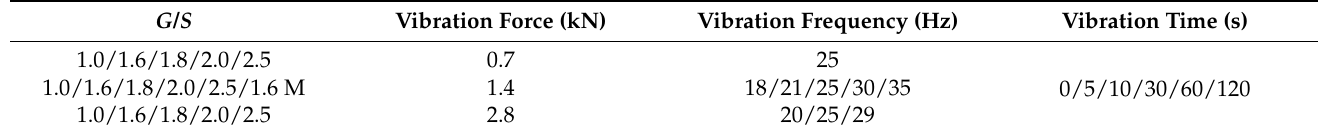
Table 3. Testing matrix of laboratory plate vibratory compaction